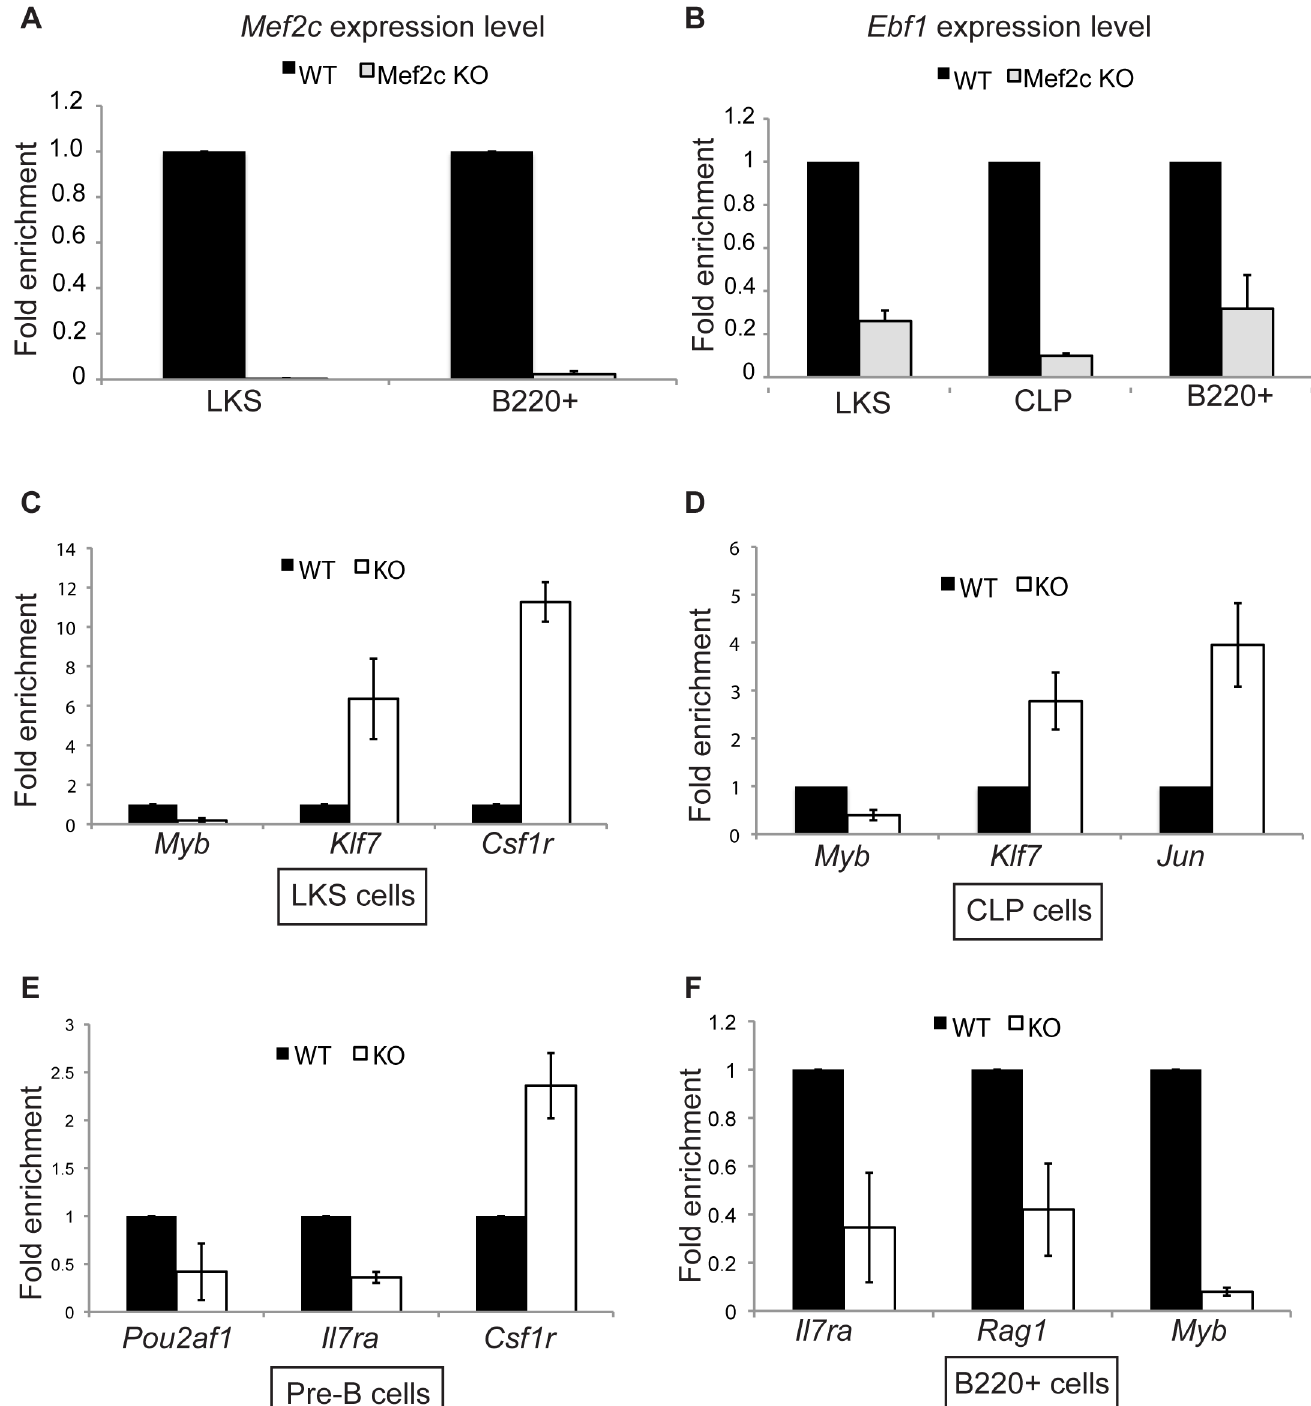
Fig 4. Relative expression levels of various hematopoietic genes in different lineages. (A) Relative expression levels of Mef2c in LKS and B220+ (all B lineage) cells sorted from Mef2c -KO mice (gray bars) or WT littermates (black bars). (B) Relative expression levels of Ebf1 in LKS, CLPs, and B220+ cells sorted from same mice as in (A). (C)-(F) Relative expression levels of various B cell genes ( Myb , Pou2af1 , Il7r , and Rag1 ) and myeloid genes ( Klf7 , Csf1r , and Jun ) in LKS, CLPs, Pre-B, or B220+ cells sorted from Mef2c -KO mice (white bars) or WT littermates (black bars) as determined by qRT-PCR. Experiments were performed in either technical triplicates or biological